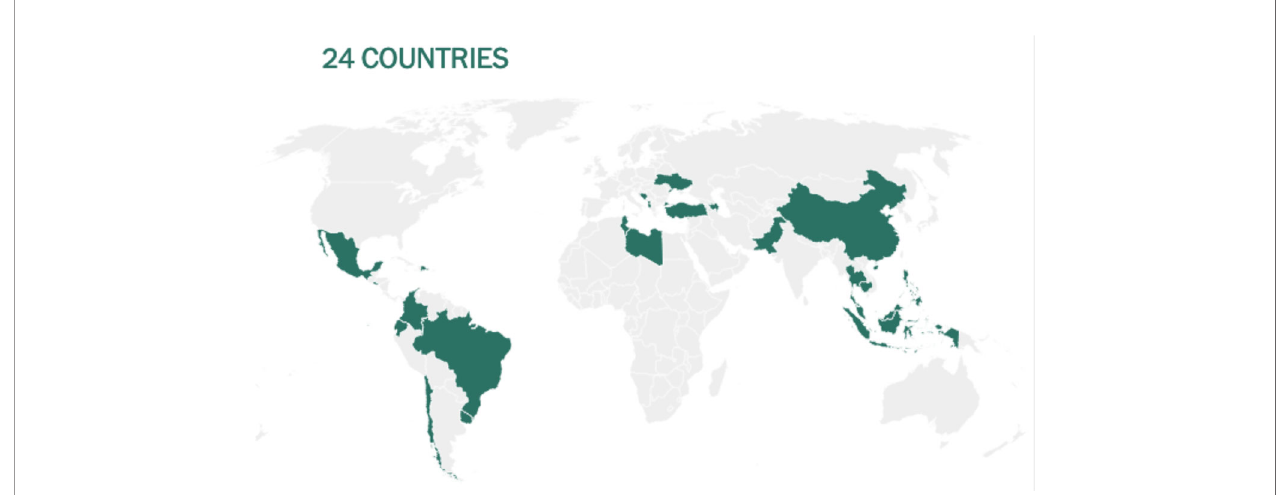
FIGURE 14 | Countries where the CoronaVac (Sinovac) vaccine is being used as of May 10, 2021. Source: Our World in Data